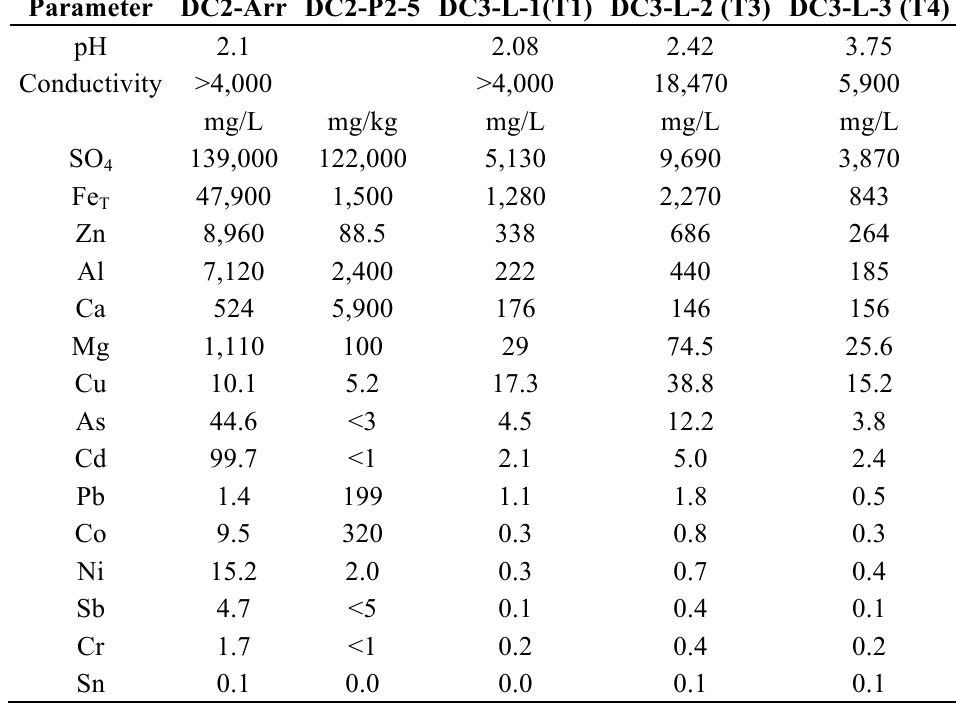
Table 4. The pH, conductivity, and concentration of sulfate and metals of acid mine drainage (AMD) in mg/L. Conductivity values are given in µS/cm. Data for sample DC2-P2-5, in mg/kg, correspond to the concentration of sulfate and metals in the water-soluble fraction obtained by sequential extractions (see also Table S1).